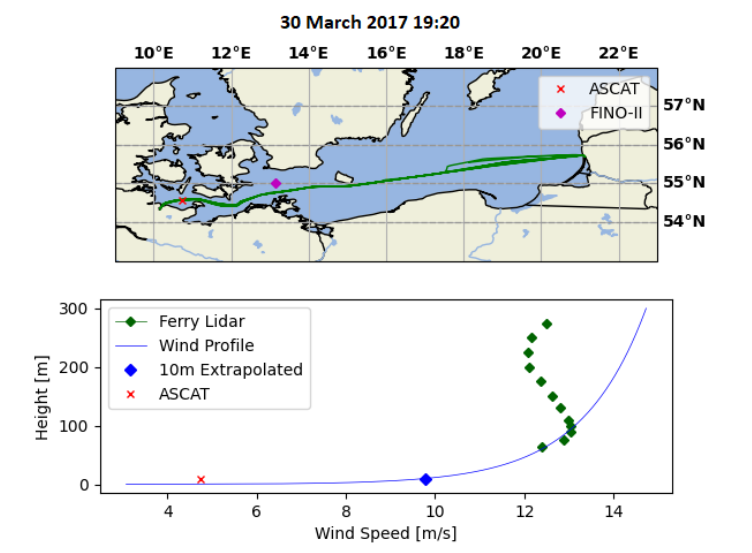
Figure 8. Wind profile extrapolation of co-located ASCAT and lidar measurements on 30 March 2017 with an